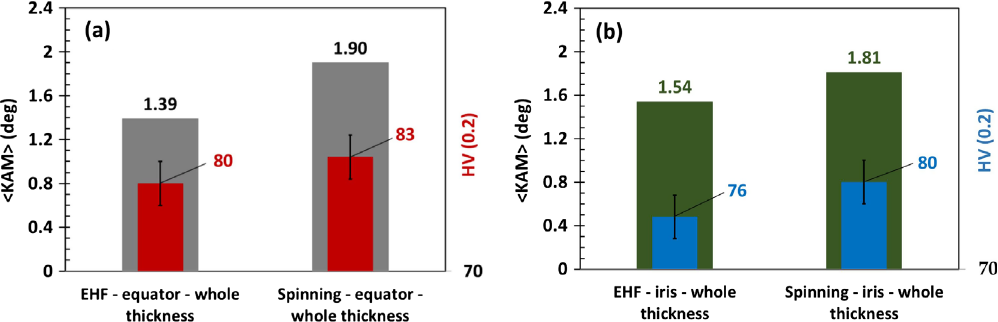
FIG. 20. Weighted average KAM ( h KAM i ) and average hardness values measured through the whole thickness: (a) specimens extracted from equator; (b) specimens extracted from iris.